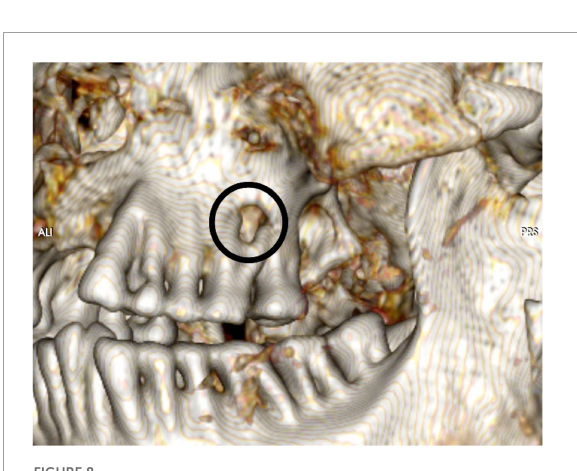
FIGURE8 Detailed view of teeth at the left maxilla shows a dental apical defect very suggestive of an apical dental (root; tooth 26) abscess